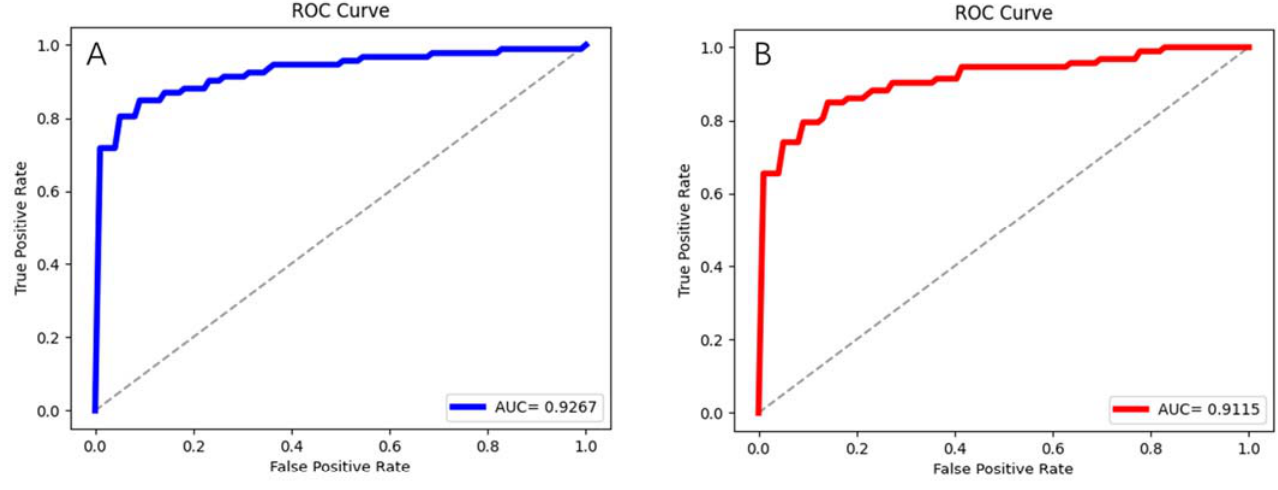
Figure 4. ROC and corresponding AUC of each prediction model on the validation set. where ( A – C ) represent the results of ResNet ‐ 34, ResNet ‐ 18, VGG ‐ 16, respectively. 4. Discussion This paper constructed deep learning models to accurately predict whether HE oc ‐ curs in patients with cerebral hemorrhage with hypertension. The deep learning frame ‐ work set up automatic segmentation, extracted imaging features, and classified them. Through comparison, it was found that the best performance in the segmentation models is U ‐ Net with attention, reaching 0.9025 mIoU. ResNet ‐ 34 performs best in predicting HE, with an AUC of 0.9267. This is the first report to integrate preprocessing, automatic seg ‐ mentation, feature extraction, and HE prediction. Attention U ‐ Net introduced an attention mechanism based on U ‐ Net, using an atten ‐ tion module to readjust the output features of the encoder before stitching the features on each resolution of the encoder with the corresponding features in the decoder. The mod ‐ ule generates a gated signal that controls the importance of features at different spatial locations. This mechanism focuses attention on the target region, which is simply to make the value of the target region larger. U ‐ Net with attention performs well in the segmenta ‐ tion tasks of medical imaging, which is closely related to its model architecture. This study introduced it into the HE classification and found that this model is superior to traditional U ‐ Net and U ‐ Net++. ResNet ‐ 34 outperforms ResNet ‐ 18 and VGG ‐ 16 in this experiment. We believe that there are the following reasons. First, the input sample size reaches 1985 slices, and the texture characteristics of the hematoma area are more complex, which makes the training